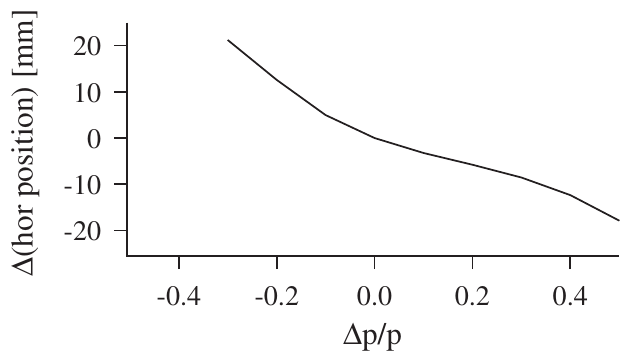
FIG. 10. Relative horizontal orbit position at the exit of the dispersion suppressor as a function of momentum deviation. Zero corresponds the orbit position of a reference momentum particle.